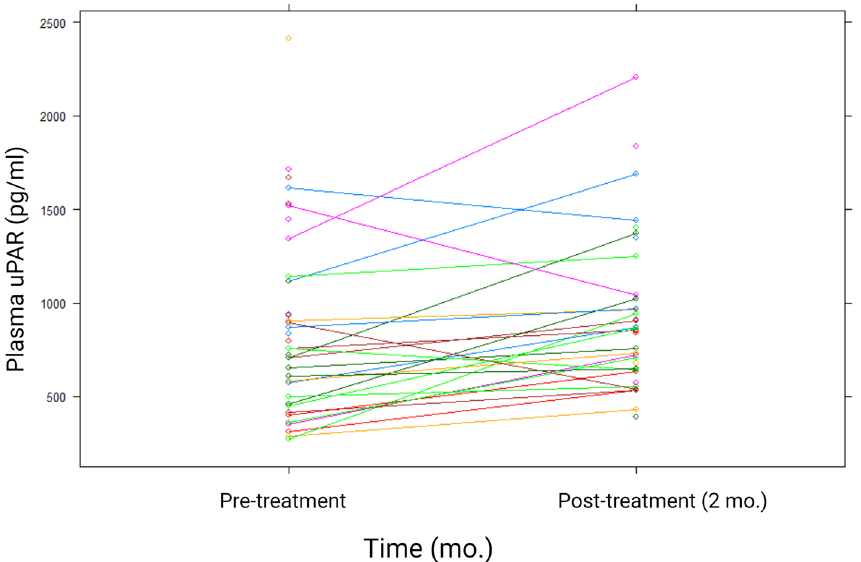
Figure 1. Plasma uPAR development during radiotherapy. Development in plasma uPAR levels in blood samples collected before and 2 months after curatively intended radiotherapy in head and neck squamous cell carcinoma patients.